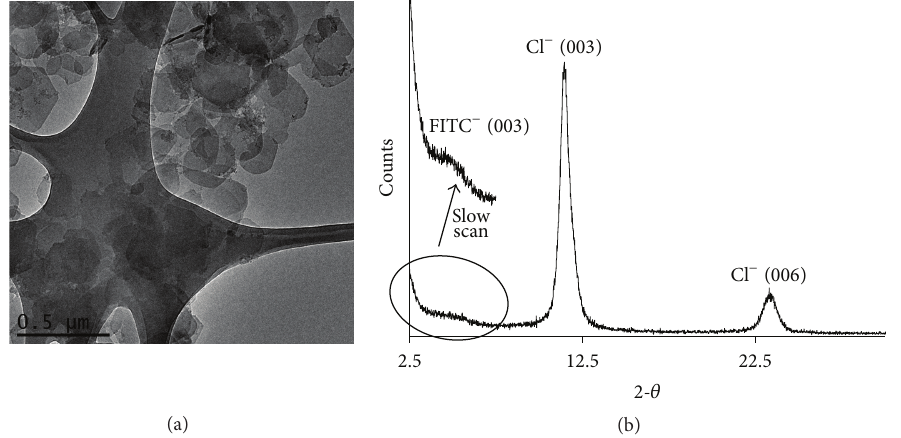
⋅ x H 𝑥 ≈ 0.15 , in (a); the corresponding XRD pattern is shown in (b), Cl 1− 2 O, x x